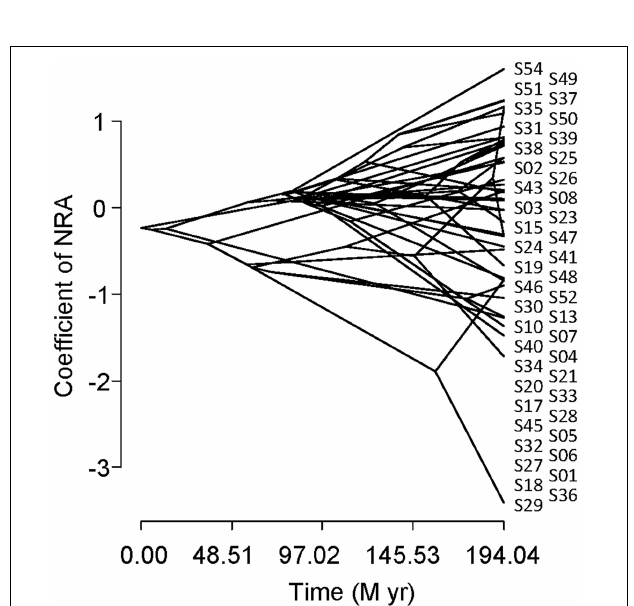
FIGURE 5 | Phylogenetic traitgram indicating the nitrate reductase activity of leaves collected inside and outside of the exclosure fence from the understory of a Zelkova serrata plantation at the University of Tokyo Chichibu Forest.